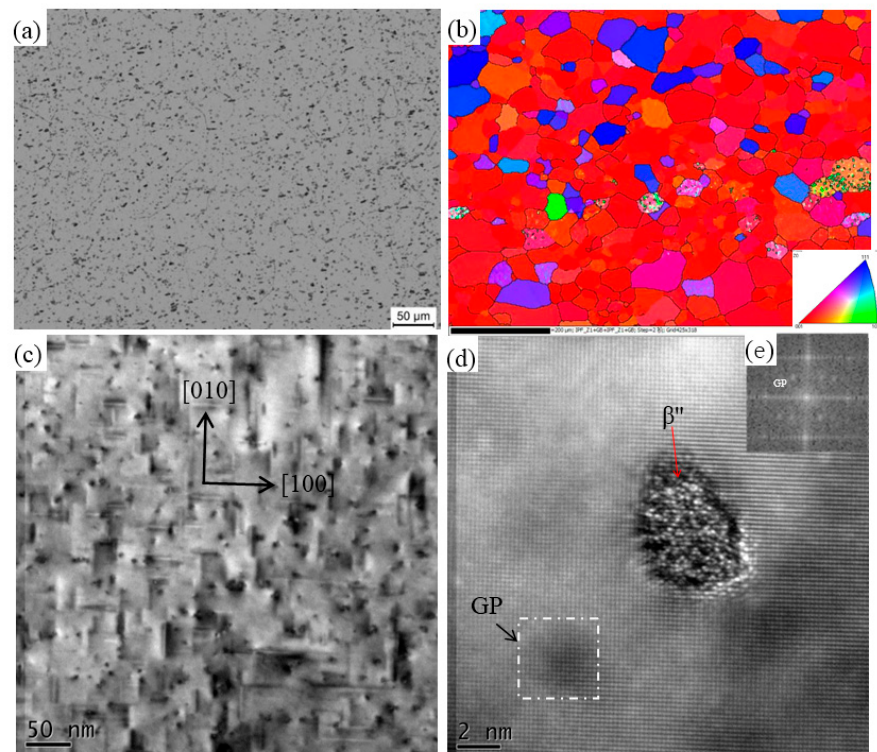
Figure 1. Microstructures of 6060-T4 ( a ) optical microscopy (OM); ( b ) Orientation image map (OIM); ( c ) transmission electron microscopy (TEM); ( d ) high-resolution transmission electron microscopy (HRTEM); and, ( e ) Fast Fourier Transform (FFT) of the marked GP zone.